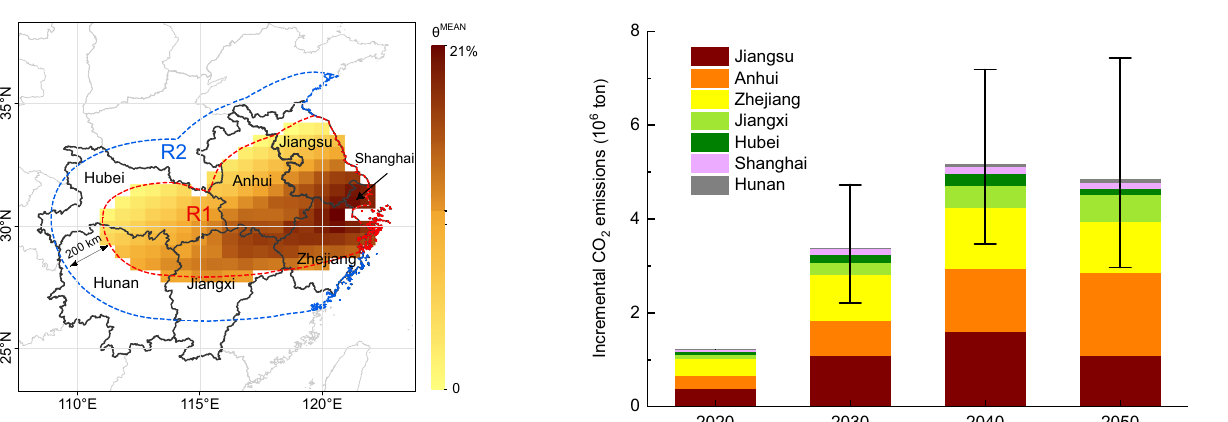
denotes the mean impact degree of plum MEAN